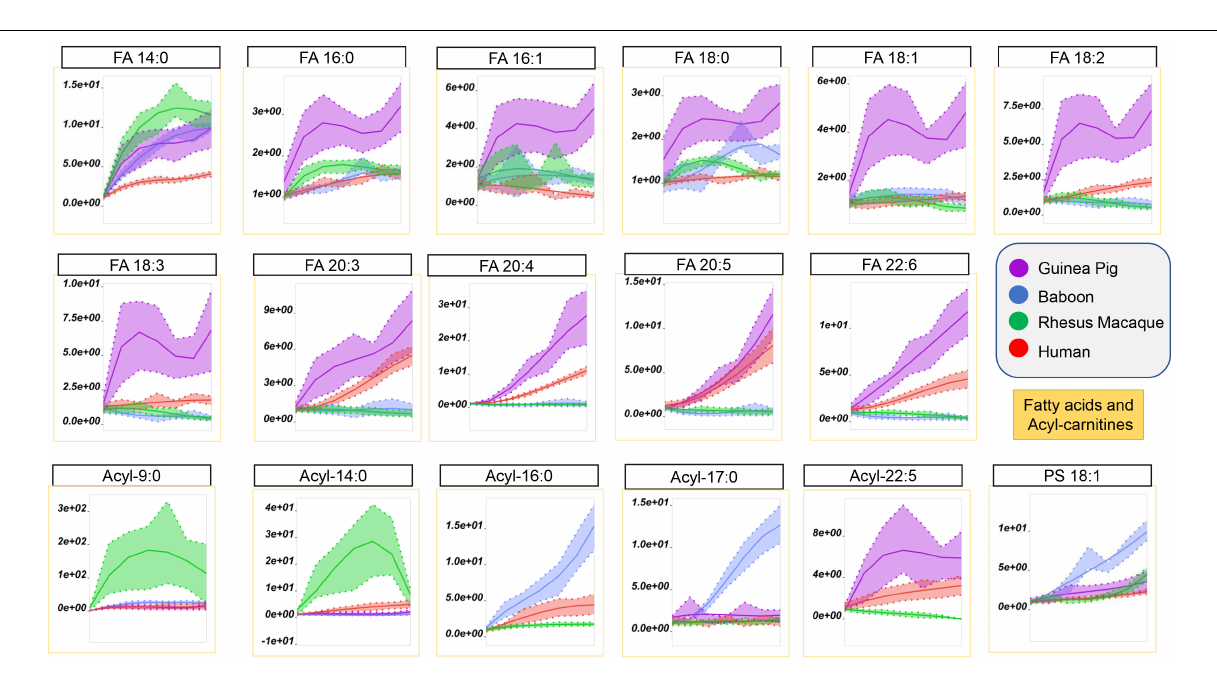
Frontiers in Physiology |